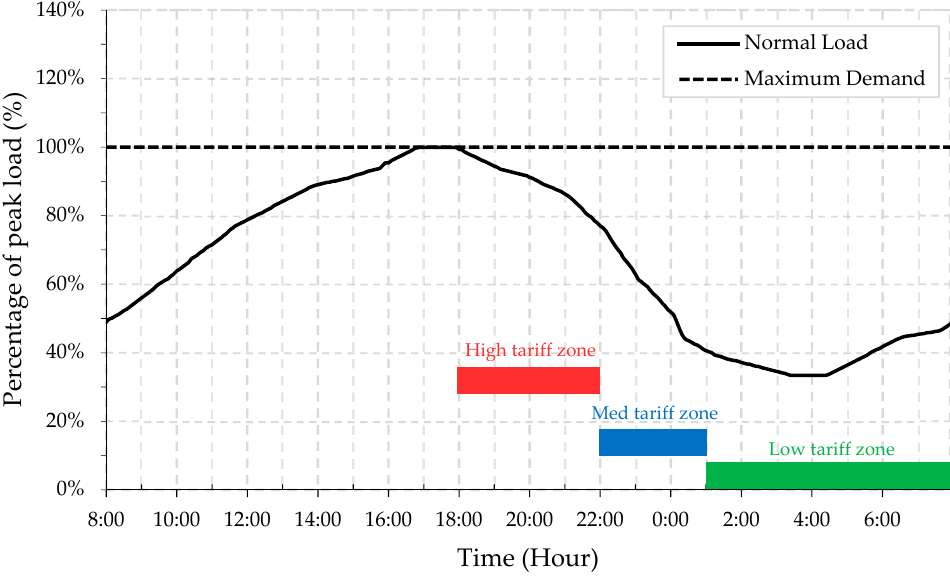
Figure 4. Daily residential load curve of LV radial distribution system. Four EV penetration levels of 16%, 32%, 47%, and 63% are assumed to cover the wide range of EVs’ charging consequences in near future. Total number of EVs connect- ed to all the LV residential feeders for each penetration level is shown in Figure 5.